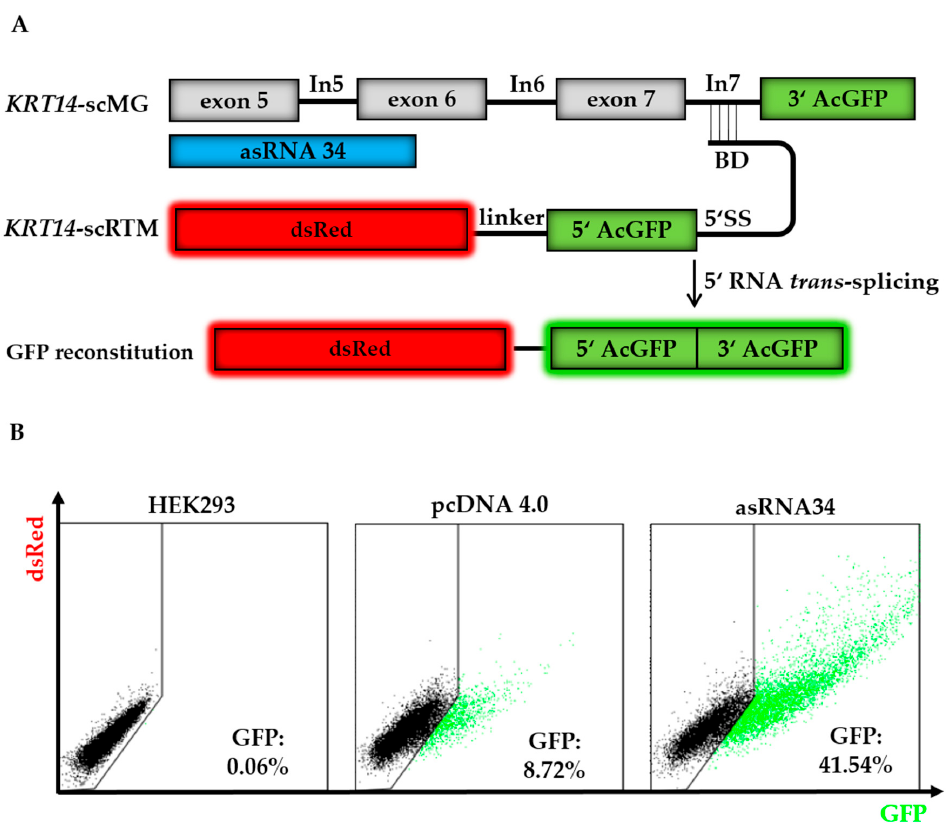
Figure 4 . asRNA34 increases trans -splicing efficiency in GFP-split model. ( A ) The co-delivery of the screening molecules ( KRT14 -scRTM and KRT14 -scMG), carrying the respective GFP parts, results in full-length GFP expression upon accurate RNA trans -splicing. The addition of asRNA34, specific for KRT14 exon 5 to exon 6, into HEK293 cells is expected to increase the level of RNA trans -splicing represented by the amount of restored GFP in the cells; ( B ) triple-transfection experiments with the KRT14-sc MG, the KRT14 -scRTM, and asRNA34 in HEK293 cells led to an increase in GFP-expressing cells from ~9% (empty pcDNA4.0) to ~42%, measured by flow cytometry. BD, binding domain; 5 ′ SS, 5 ′ splice site.